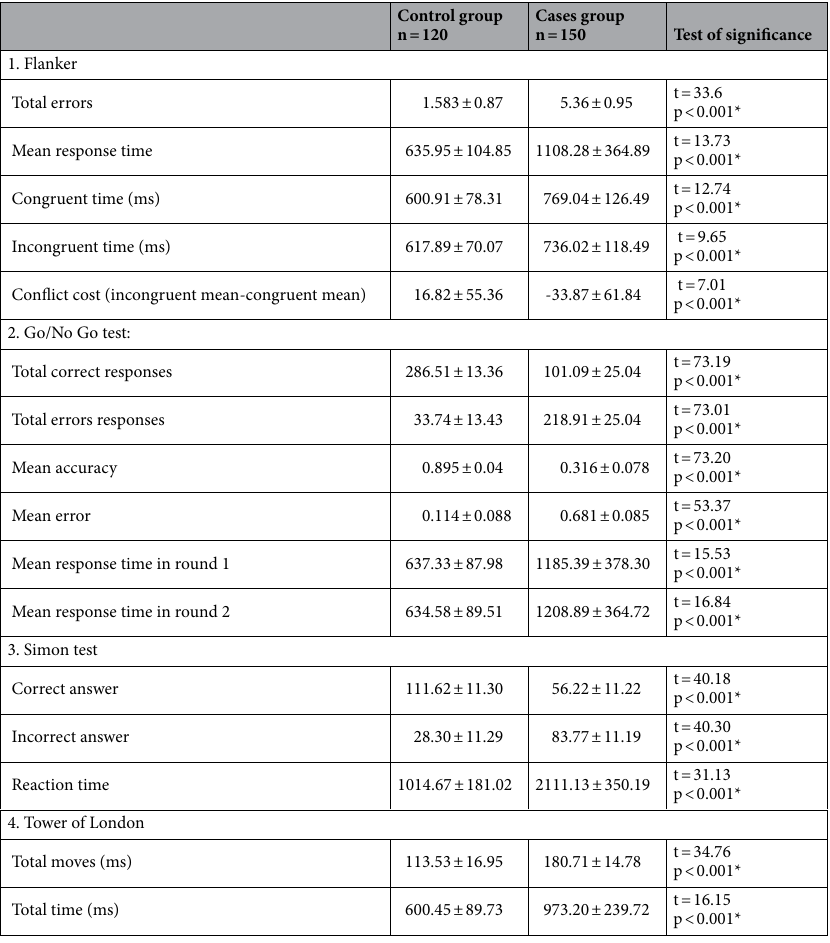
Table 4. Comparison of cognitive and executive tests between studied groups. t: Student t test, *statistically significant if p < 0.05, parameters described as mean ± SD.